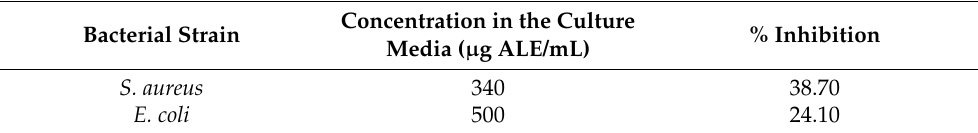
Table 5. Antimicrobial activity of the polyester dressings impregnated with ALE at 400 bar, 55 ◦ C and using 10% ethanol and 5.3 mg ALE/100 mg PD